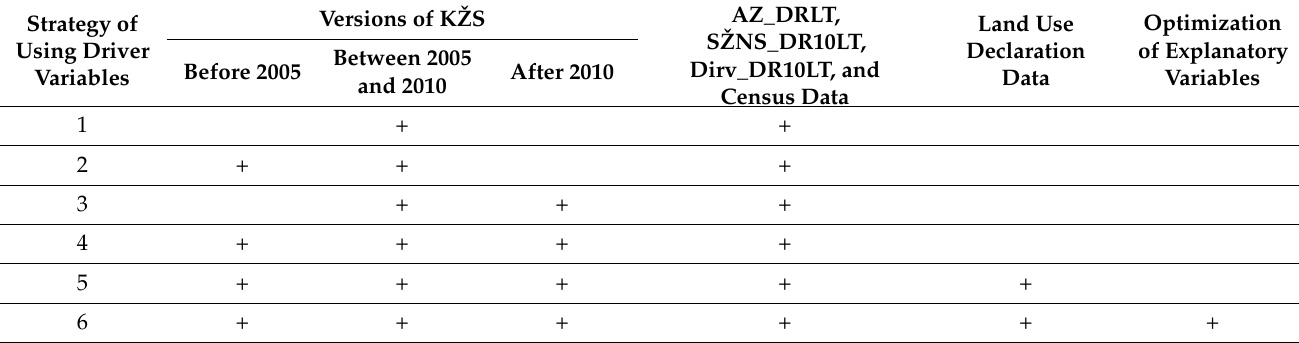
Table 1. Tested strategies for the inclusion of driver variables in building the transition potential models (+ means that the variables from the respective group were considered or an optimization of variables was applied). Versions of Strategy of Using Driver Variables